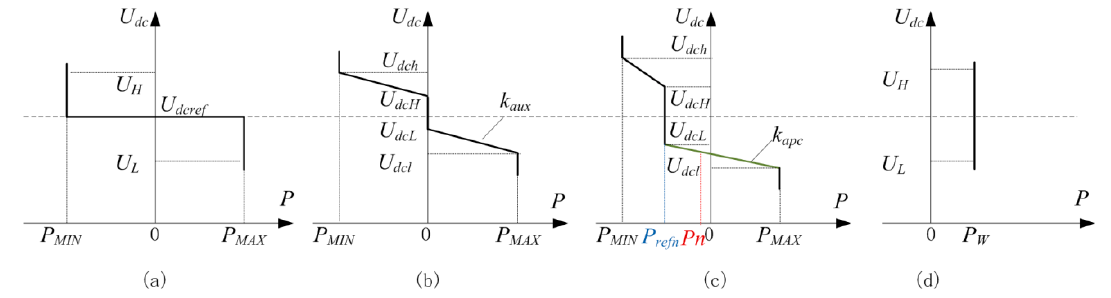
Figure 3. U dc -P characteristics of the master-auxiliary control strategy. ( a ) U dc -P characteristics of the master converter. ( b ) U dc -P characteristics of the auxiliary converter. ( c ) U dc -P characteristics of the active power converter. ( d ) U dc -P characteristics of the wind farm converter.